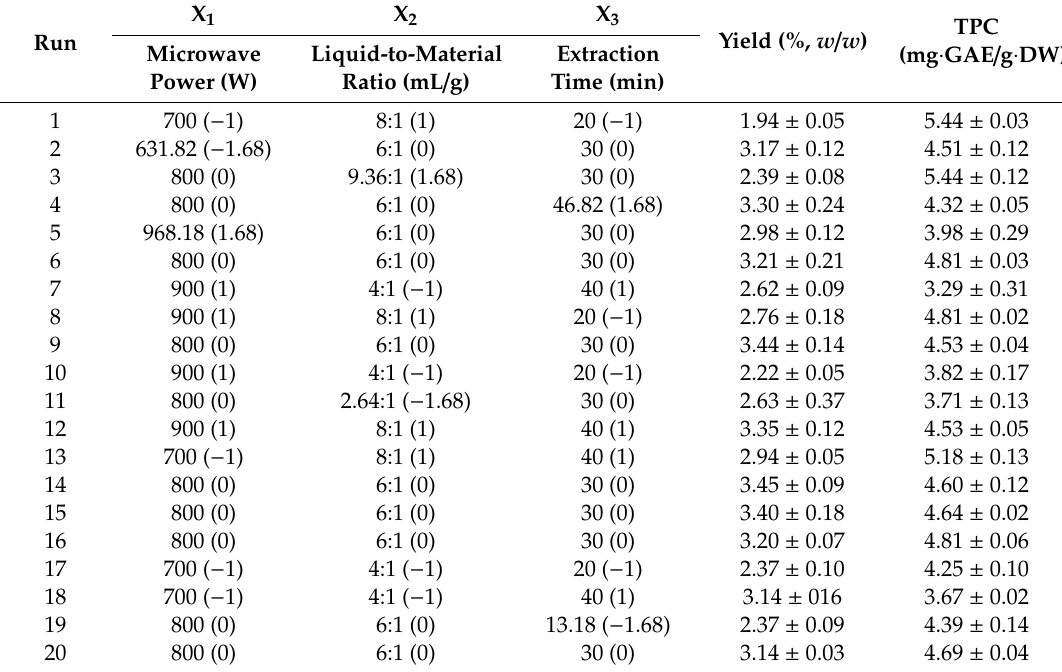
Table 1. The experimental design and response values of central composite design